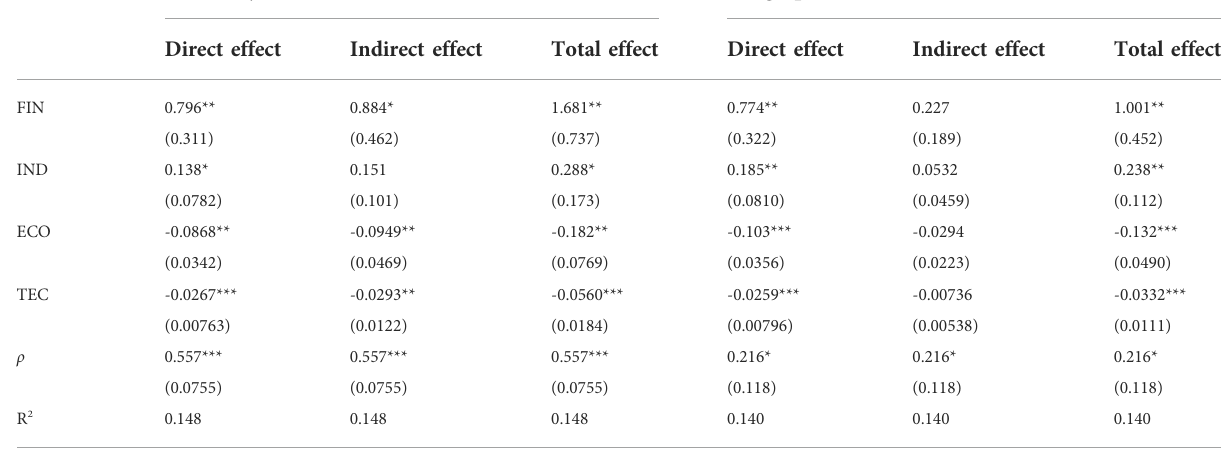
TABLE 8 SAR model decomposition estimation